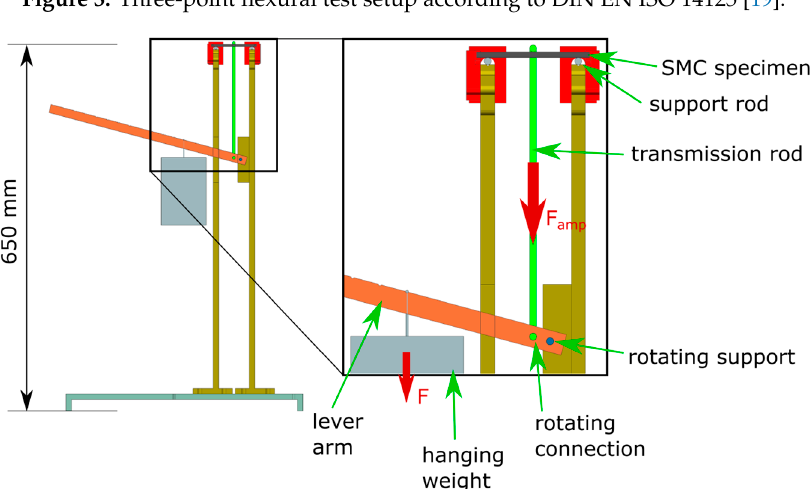
Figure 4. Schematic drawing of the used test fixture for measurement of creep deformation under flexural load.